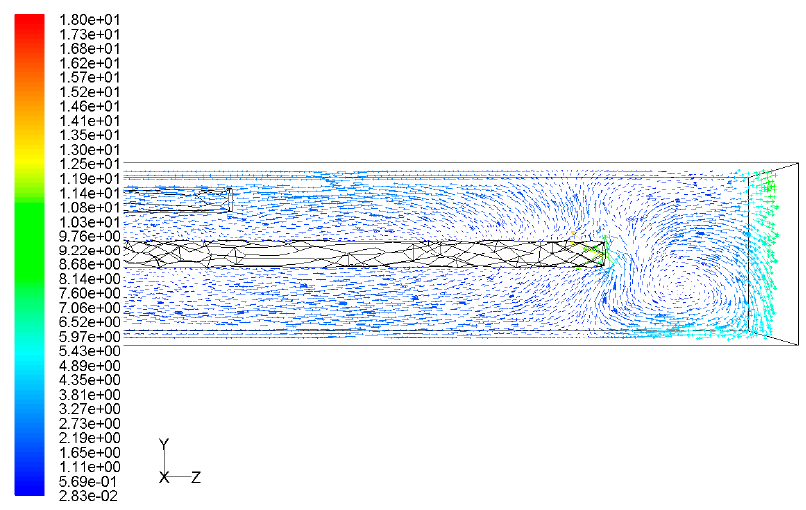
Figure 5. Airflow velocity vector 2 m away from the side wall (m/s).